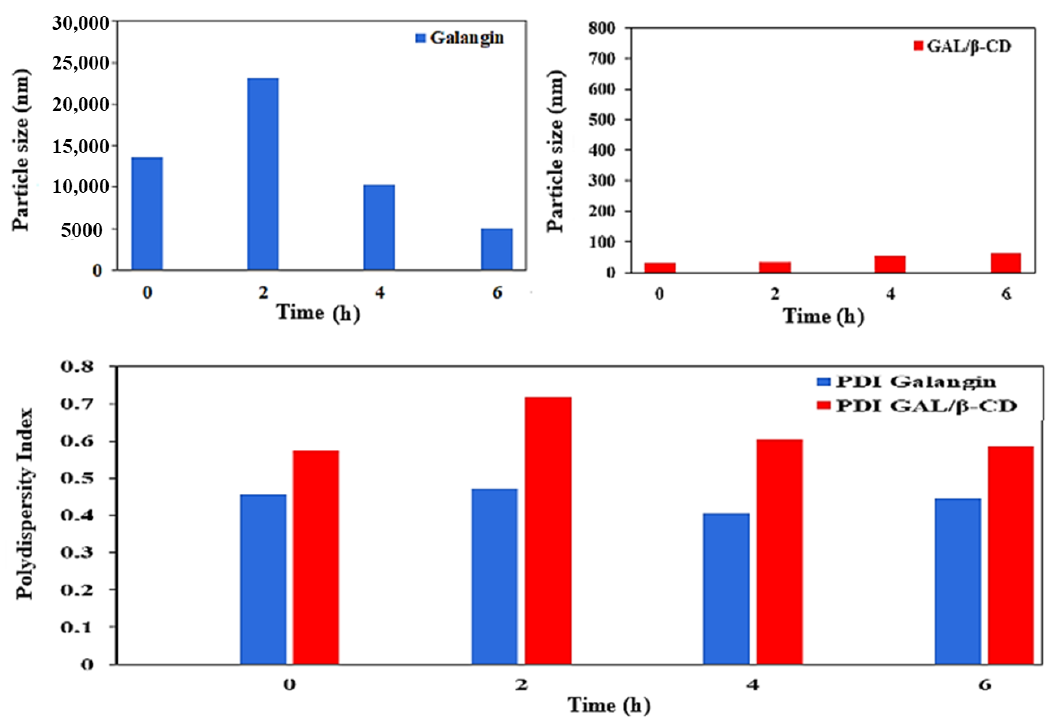
Figure 7. Serum stability of pure galangin and GAL/ β -CD for 6